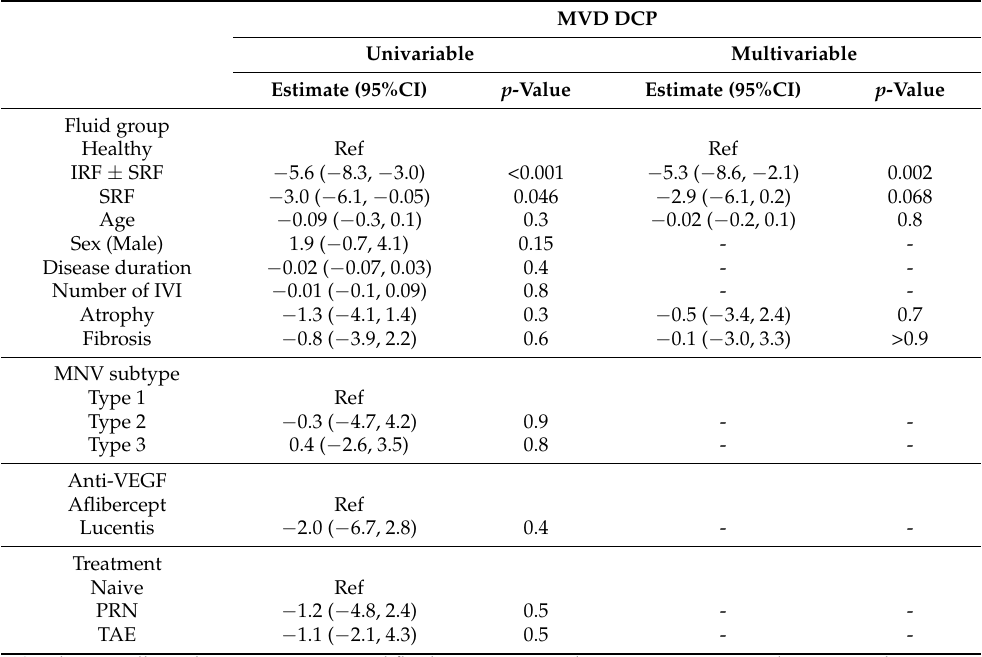
Table 5. Mean vascular density (MVD) in the deep capillary plexus (DCP) according to different factors in the univariate and multivariate analyses.